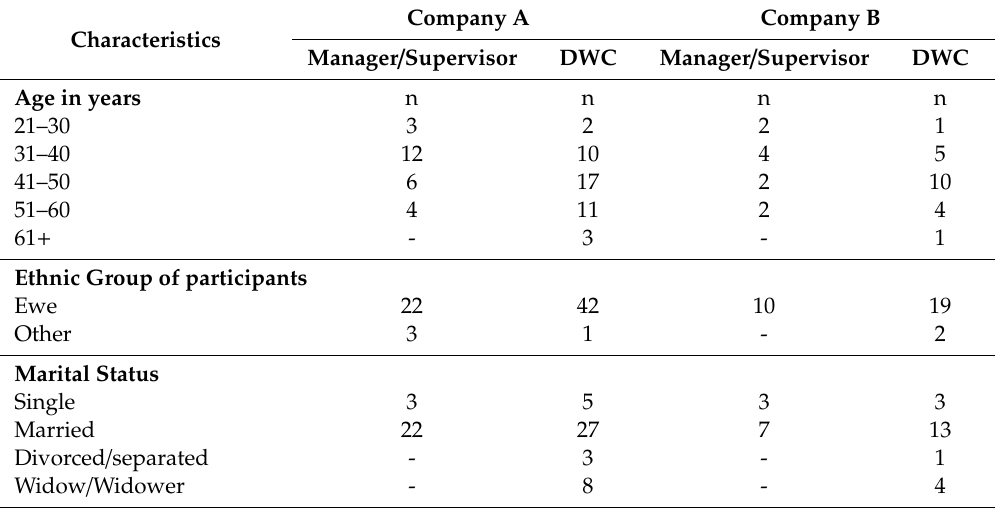
Table 1. Demographic and socio-economic characteristics of the study